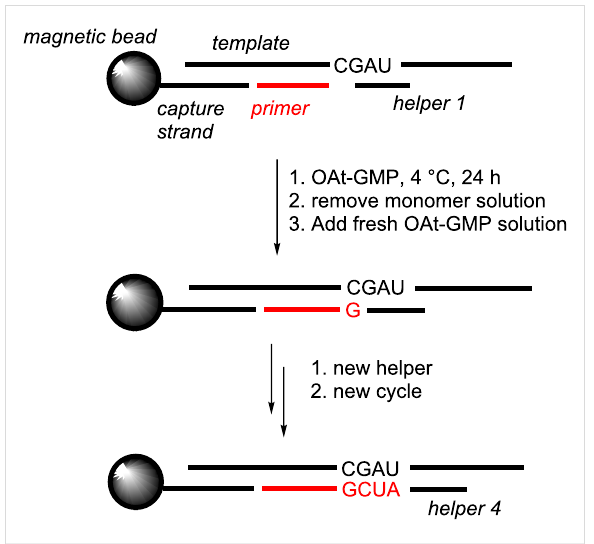
Figure 10: Copying of four nucleotides on an immobilized RNA duplex, as reported by Deck et al.